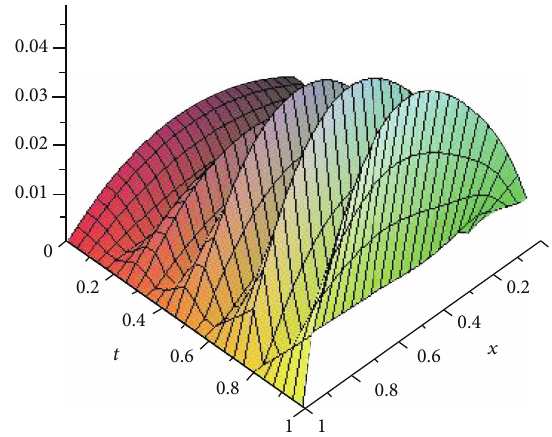
Figure 5: Plot of the absolute error 𝑒(𝑥, 𝑡) = |𝑦(𝑥,𝑡)−𝑦 𝑛,𝑘 (𝑥,𝑡)| with 𝑛 = 3, 𝑘 = 4 for Example 3.